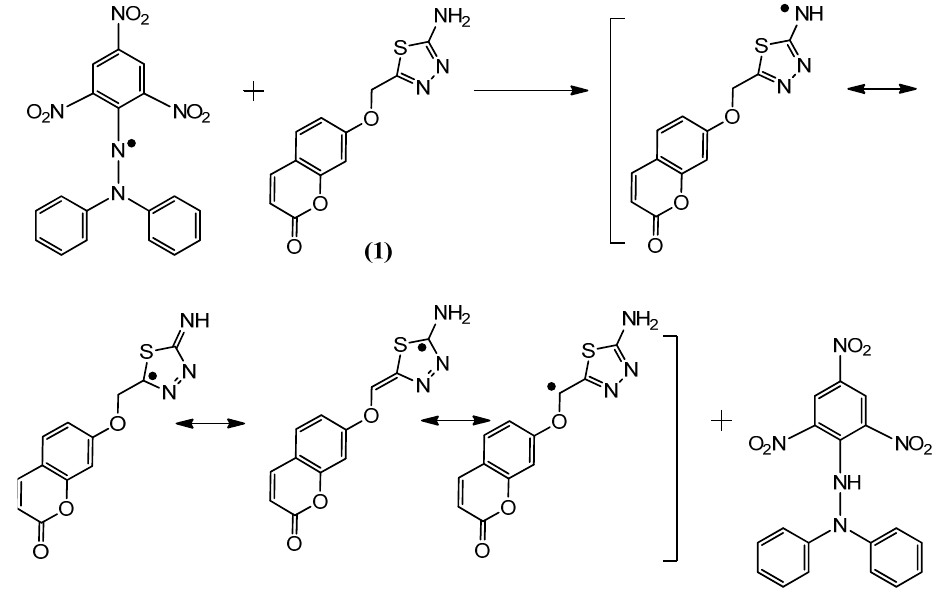
Figure 3. The reaction scheme between DPPH free radicals and compound 1 .